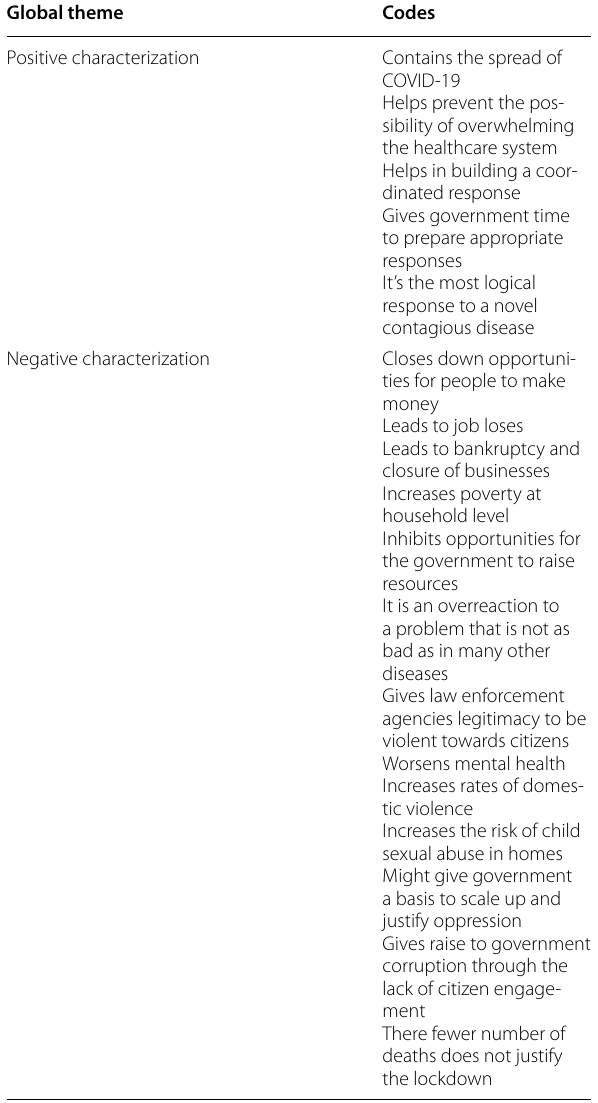
Table 1 Summary of qualitative results Global theme